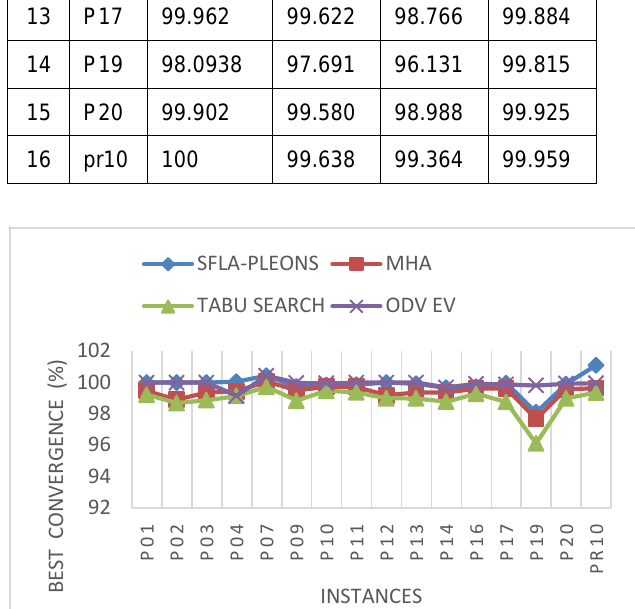
Figure 2. Performance of different technique